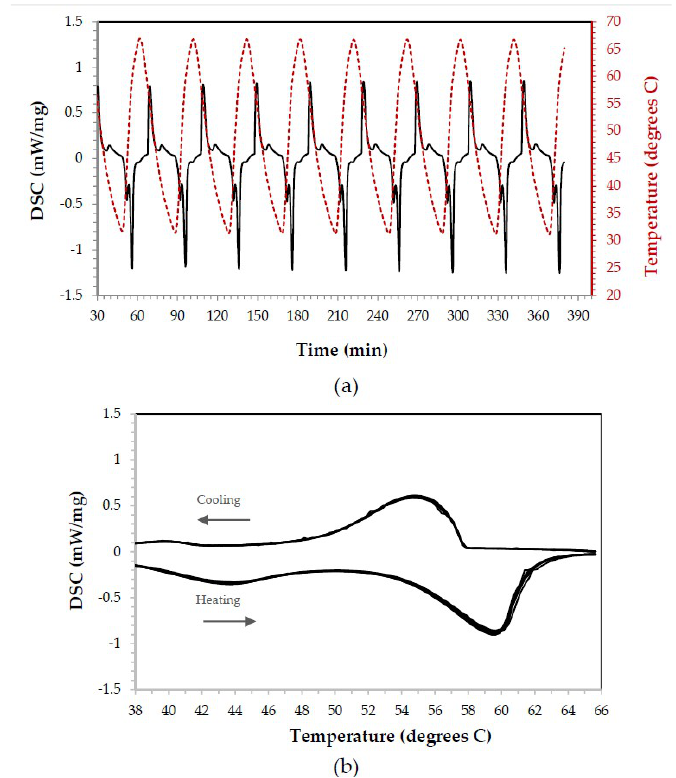
Figure 5. DSC results for paraffin over 8 cycles. ( a ) Performance over time, ( b ) endothermic and exothermic peaks observed during the melting and solidification processes, respectively. Exothermic peaks up, endothermic peaks